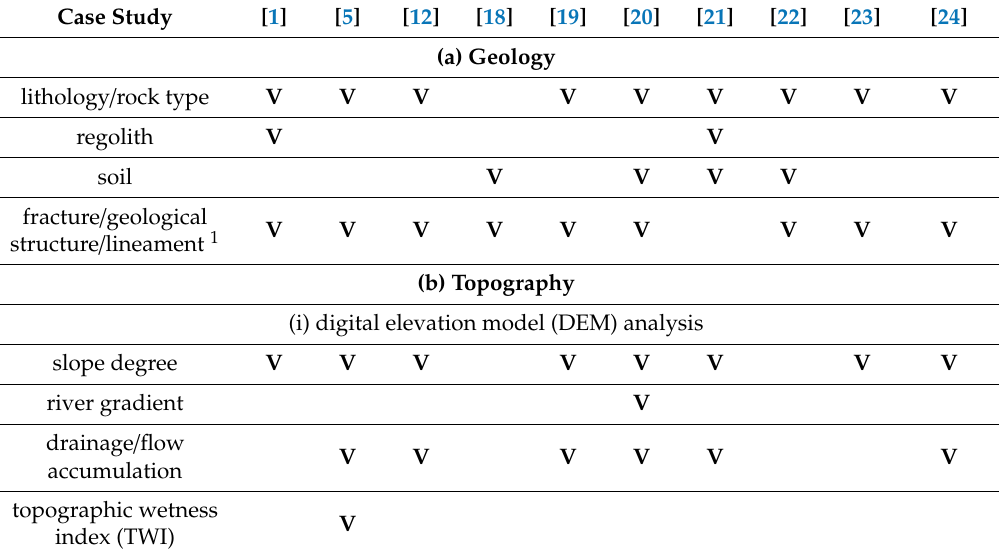
Table 1. Lists of literature and parameters in remote sensing (RS)- and geographic information system (GIS)-based